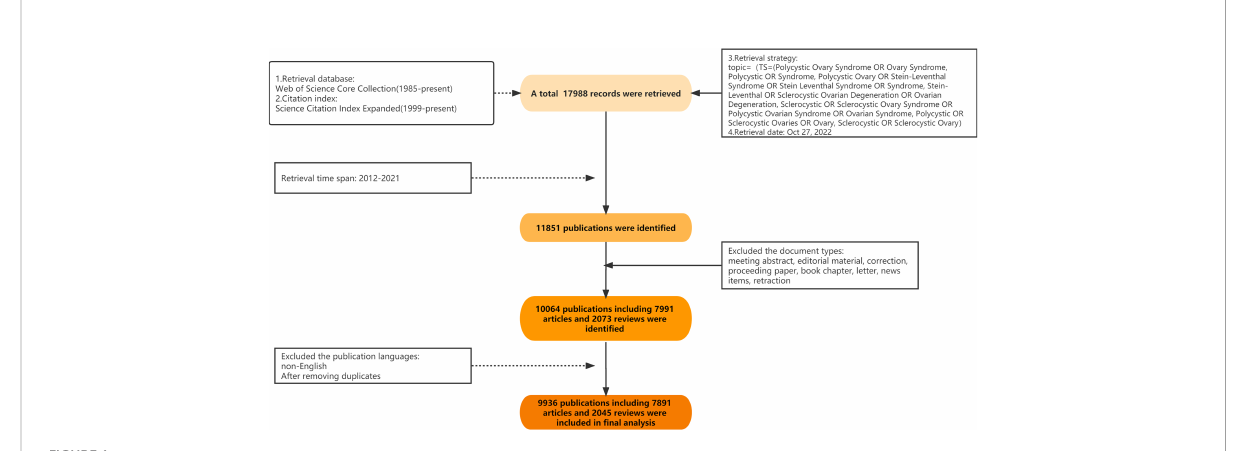
FIGURE 1 Flowchart of literature search and selection